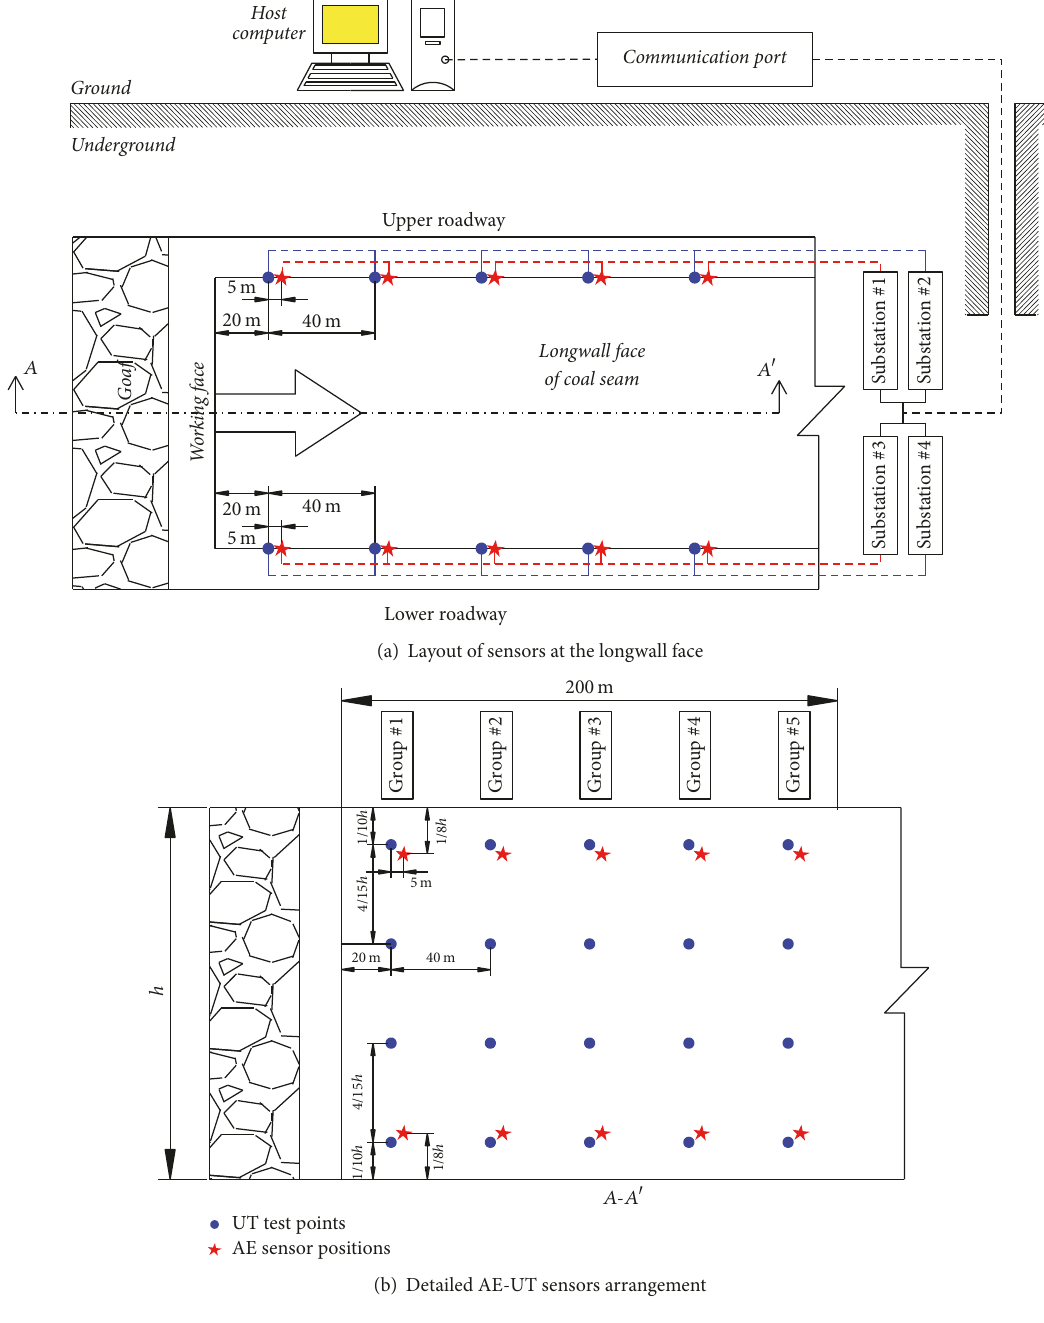
Figure 8: The AE-UT joint monitoring prospect in the coal